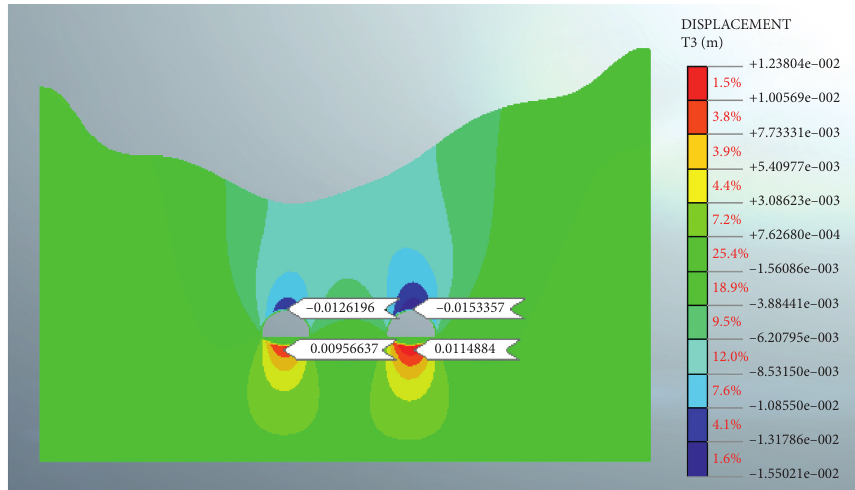
Figure 20: Vertical displacement distribution of surrounding rocks by single-side guide pit method.